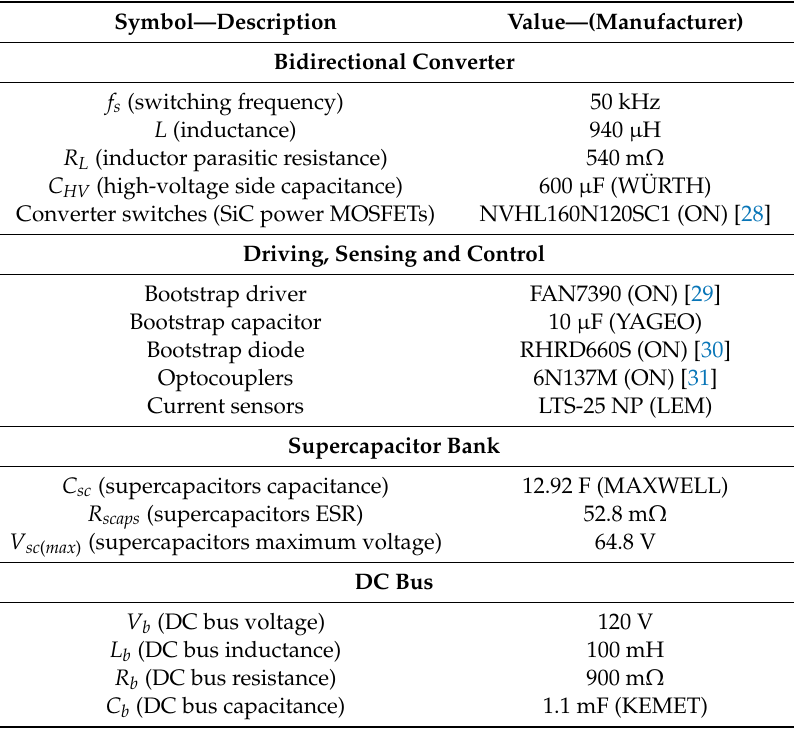
Table 1. Main test bench components and system